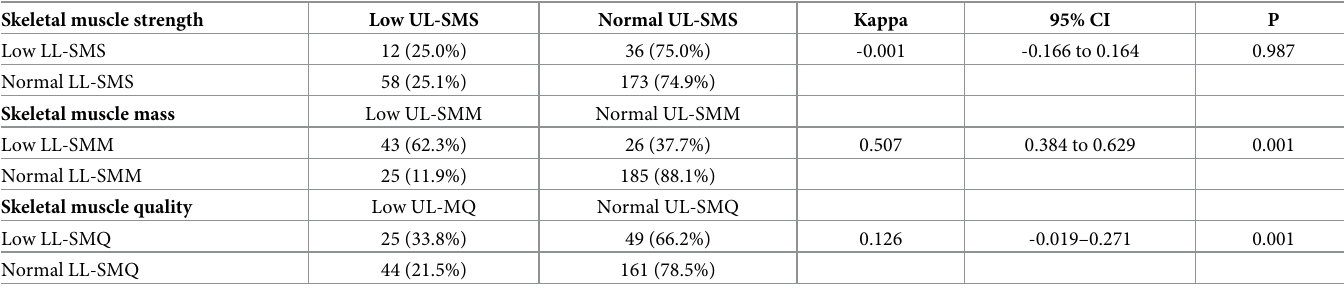
Table 5. Agreement between upper and lower limb measures to identify older females with low skeletal muscle strength, muscle mass and muscle